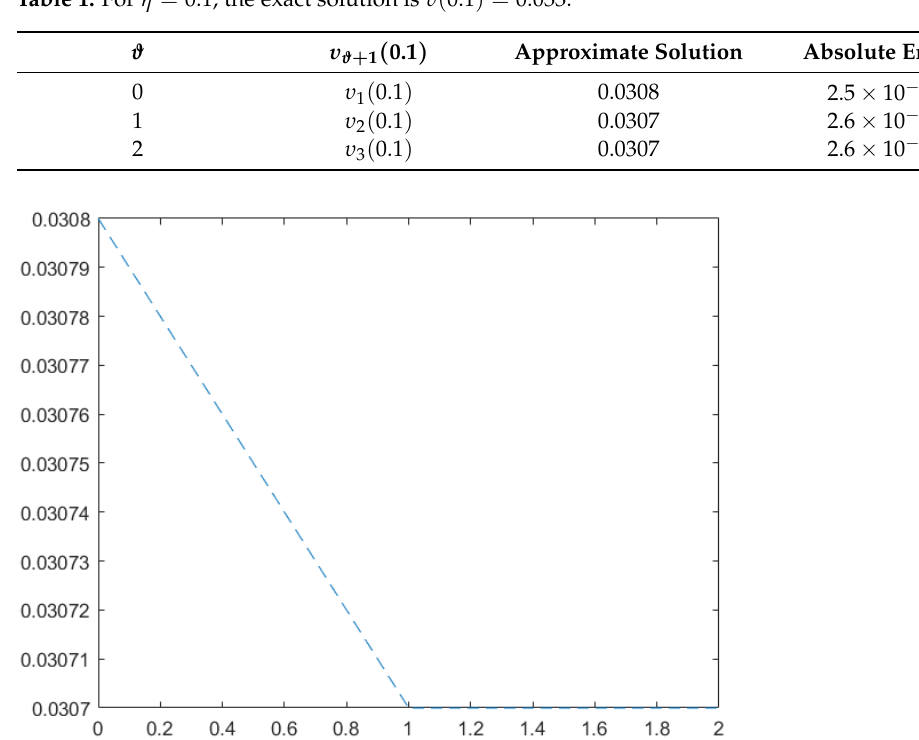
Table 1. For η = 0.1, the exact solution is υ ( 0.1 ) = 0.033.